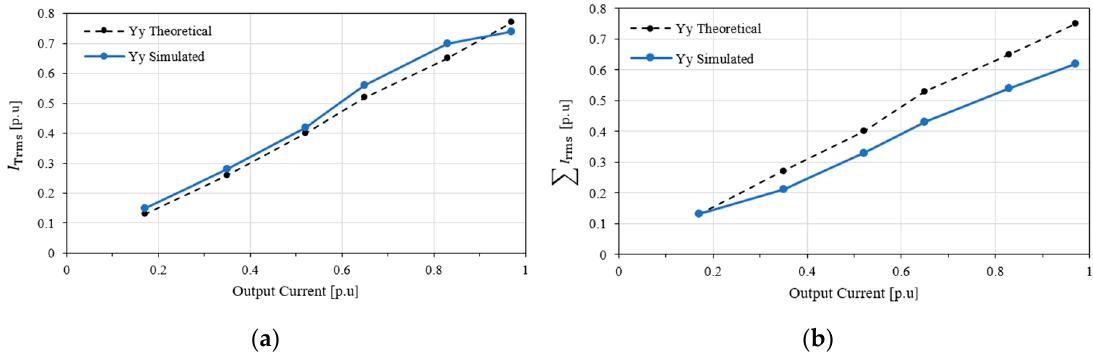
Figure 12. Comparison of theoretical and simulation results of current stress analysis. ( a ) Transformer rms current. ( b ) Summation of rms currents in one phase of bridges 1 and 2 of the 3P-BIDC.